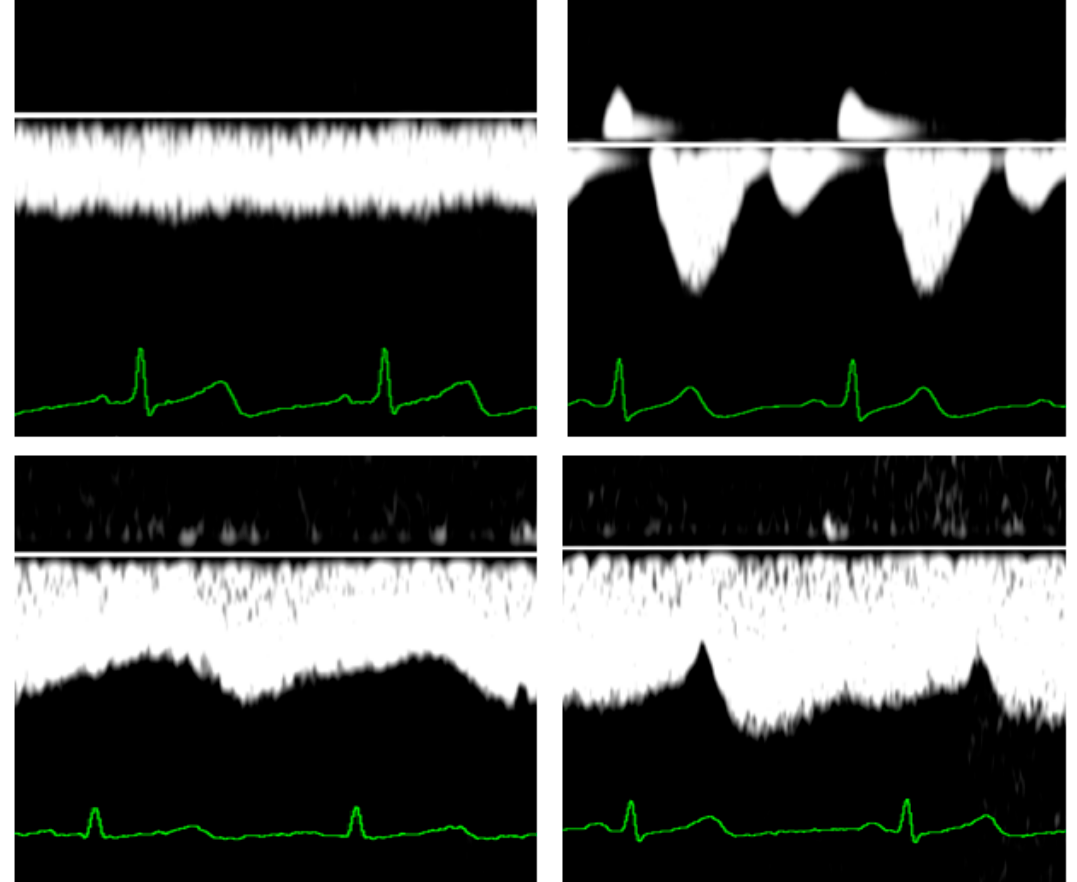
Figure 2. Venous Doppler wave forms at the level of the liver (upper panels) and the kidneys (lower panels) during normal third trimester pregnancy (left panels) and during early onset preeclampsia (right panels). The latter condition is specifically associated with the so-called venous pre-acceleration nadir (VPAN), illustrated in the right lower panel.